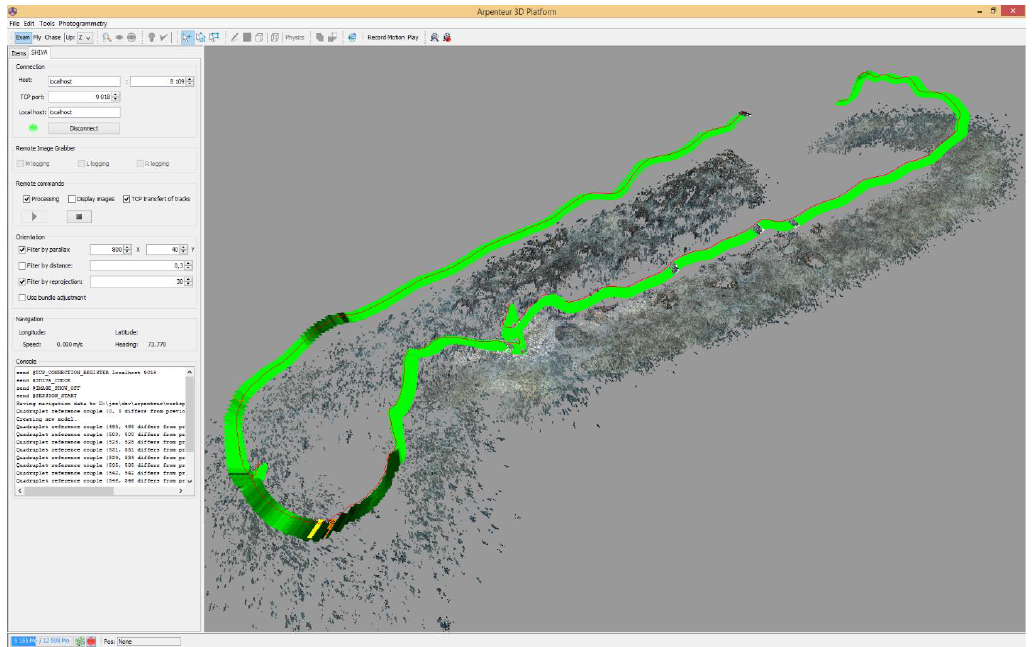
Figure 7. Real-time visual odometry as seen from the on-board computer. This figure shows the 3D point cloud calculated over the surveyed zone and the position of the vehicle for each image pair. The density of the points measured on each image is colour-coded (yellow, green and black) which gives an overview of the quality of the orientation (yellow < 30 points, green between 100 and 200 points, dark green > 300